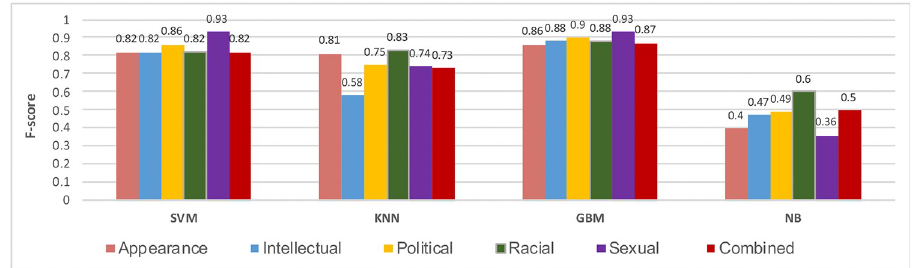
Fig 5. Comparative study of the F-score from four major classifiers i.e., SVM stands for support vector machine, KNN = K-Nearest Neighbor, GBM = Gradient Boosting Machine, NB = Naive Bayes, NN = Nueral Network).